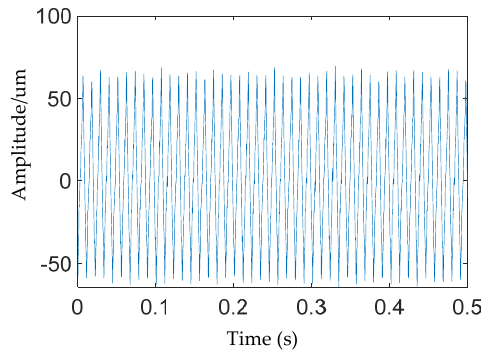
Figure 15. Time-domain waveform of fault signal.